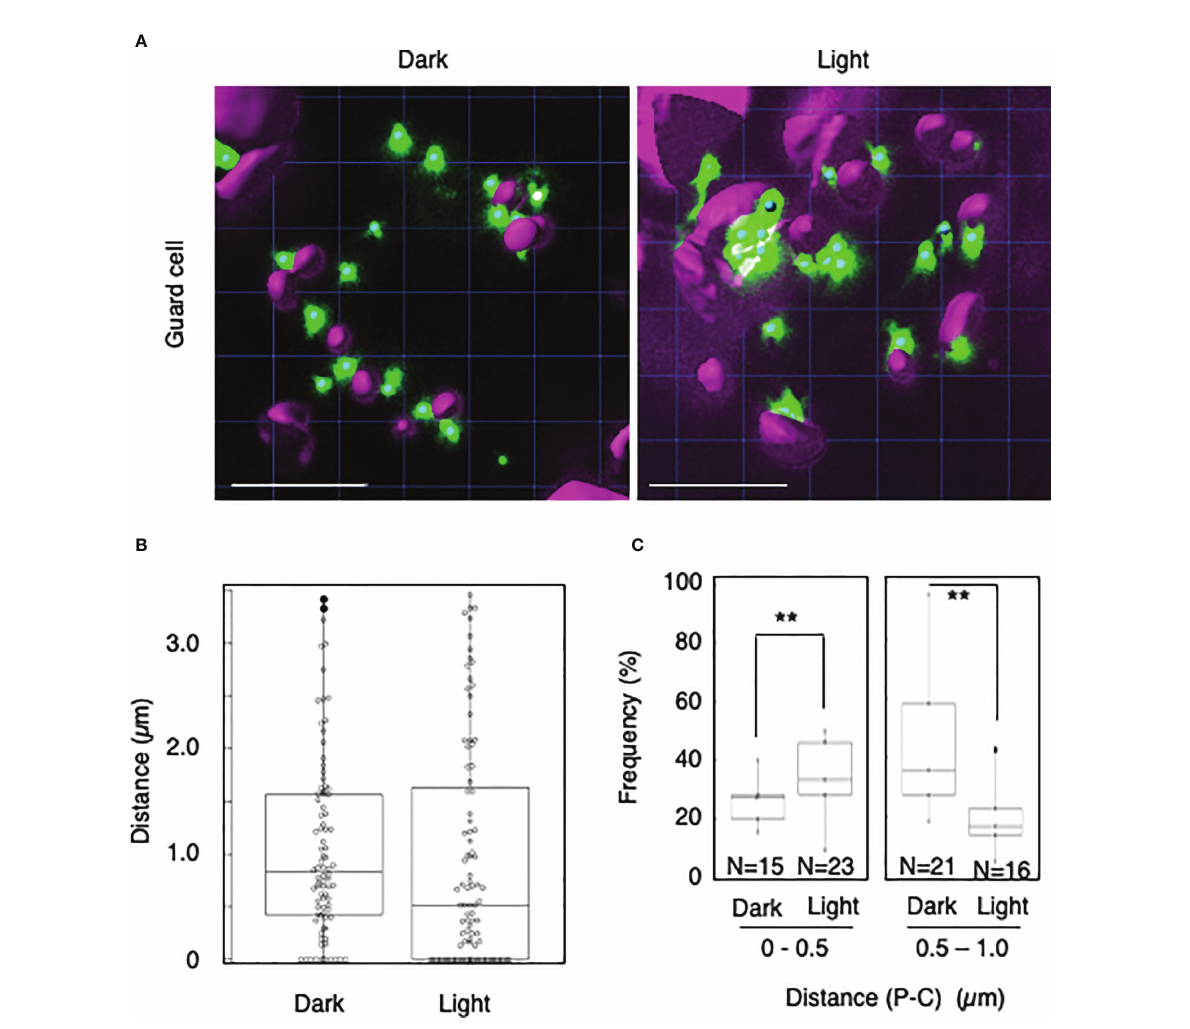
FIGURE 2 Measurement of the distances between chloroplasts and peroxisomes in guard cells. (A) Representative images of chloroplasts (magenta) and peroxisomes (green) in guard cells in the dark (left) and light (right). Bars, 10 µm. (B) Box plots of the distances between peroxisomes and chloroplasts in guard cells in the dark and light from fi ve cells. The average distance was 1.05 ± 0.87 µm (n = 88) in the dark and 1.00 ± 1.06 (n = 92) in the light. The median distance was 0.83 µm in the dark and 0.61 µm in the light. (C) Frequency of the distances between peroxisomes and chloroplasts in the dark and light. The frequency of distances of 0 – 0.5 µm was 37.7 ± 16.0% in the dark (n = 15) and 62.3 ± 16.0% (n = 23) in the light, whereas the frequency of distances of 0.5 – 1.0 µm was 59.5 ± 11.6% (n = 21) in the dark and 40.5 ± 11.6% (n = 16) in the light in (B) . ** P < 0.01, Student ’ s t